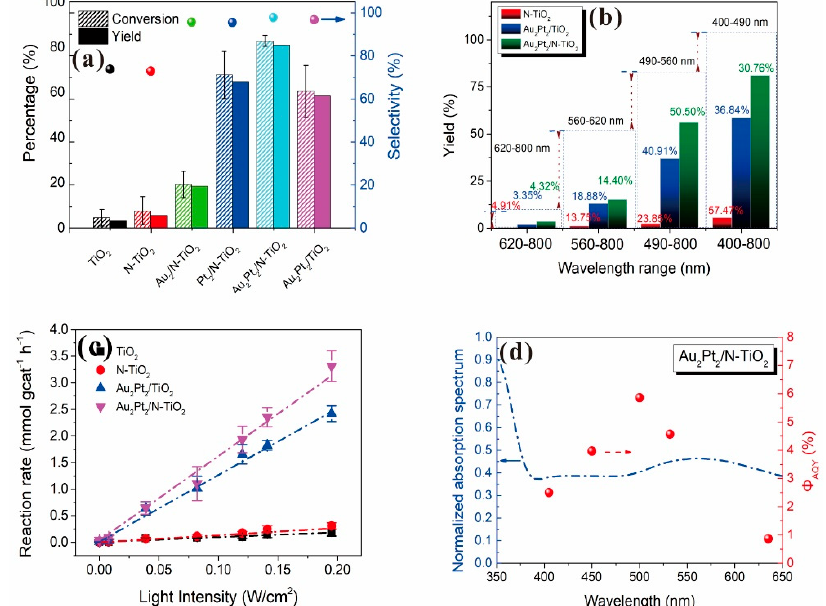
Figure 3. ( a ) Conversion, yield, and selectivity for the photo-oxidation of benzyl alcohol to benzaldehyde over prepared photocatalysts. ( b ) The dependence of yield and irradiation wavelength over photocatalysts for the selective oxidation of benzyl alcohol. ( c ) The rate of photocatalytic reaction over TiO 2 , N–TiO 2 , Au 2 Pt 2 /TiO 2 , and Au 2 Pt 2 /N–TiO 2 as a function of irradiance intensity. ( d ) Diffuse-reflectance UV–Vis spectra of Au 2 Pt 2 /N–TiO 2 photocatalyst and the quantum yield for the formation of benzaldehyde under a multiple-wavelength laser light source. The apparent quantum yield was calculated using the equation Φ AQY = (Y vis − Y dark )/ N × 100%, where Y vis and Y dark are the yields of photocatalytic reaction under irradiation or dark conditions, and N is the number of incident photons in the reaction vessel.